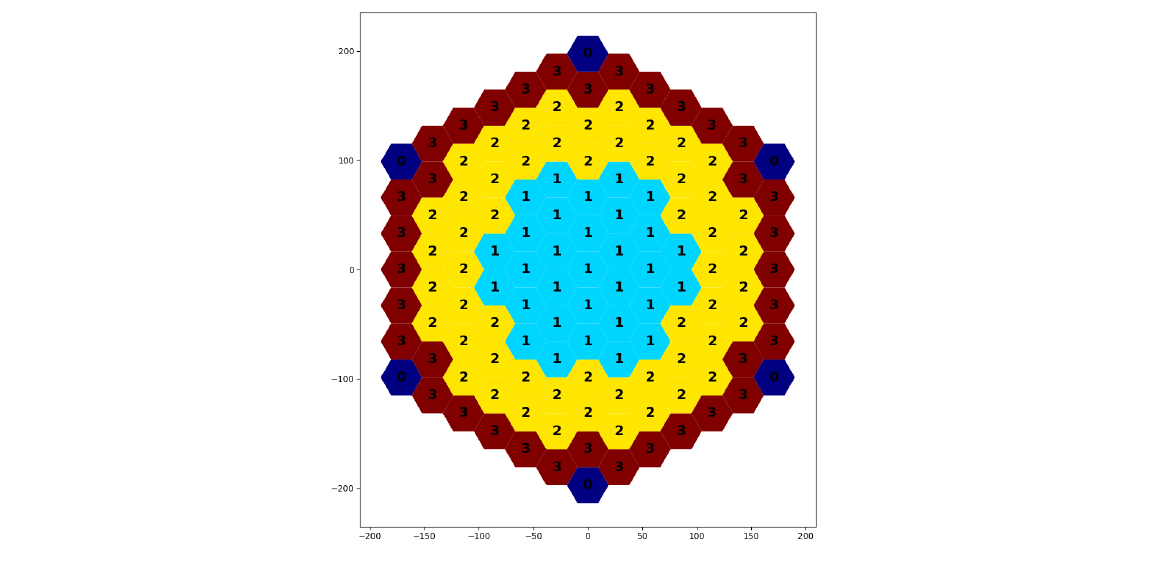
Figure 3: 2D hexagonal benchmark problem proposed by [12]. Mixture 0 is here only to complete the hexagonal geometry description, and is equivalent to